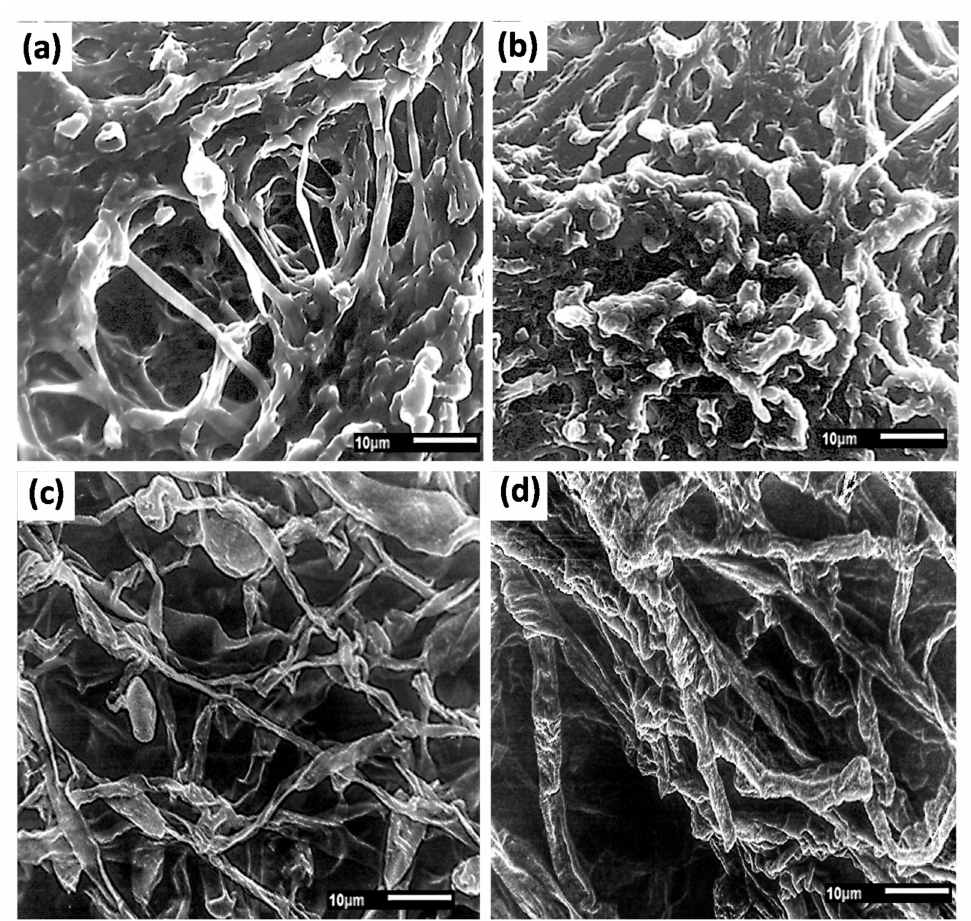
Figure3. SEMimagesof( a ) T.fasciculatum controland( b )aftertreatmentwithCd 2 + , ( c ) T.longibrachiatum control and ( d ) after treatment with Cd 2 +